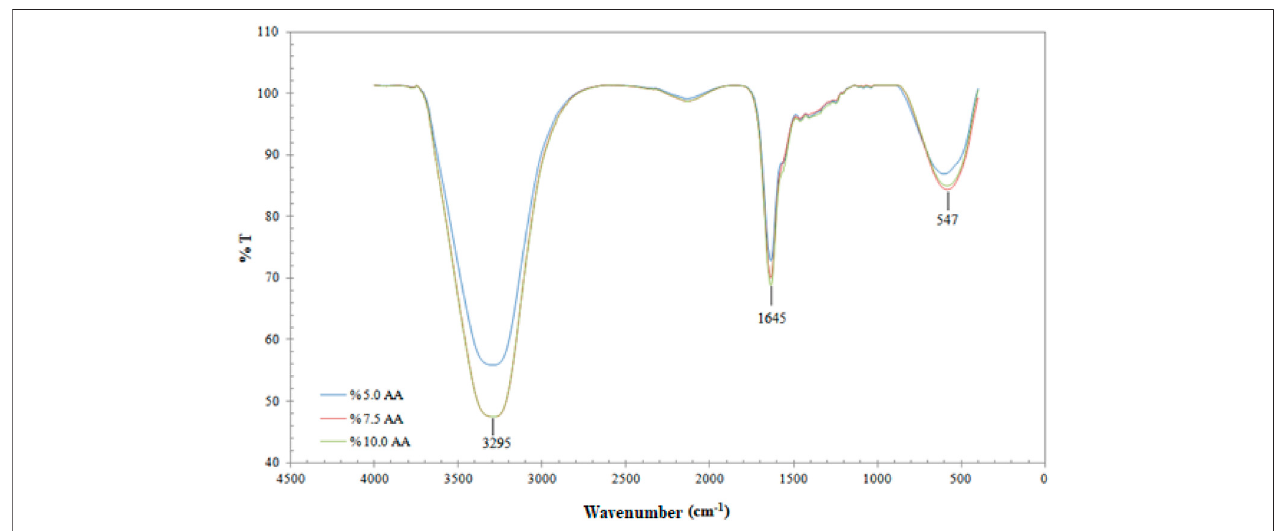
FIGURE 3 | FTIR spectra of the chitosan fi